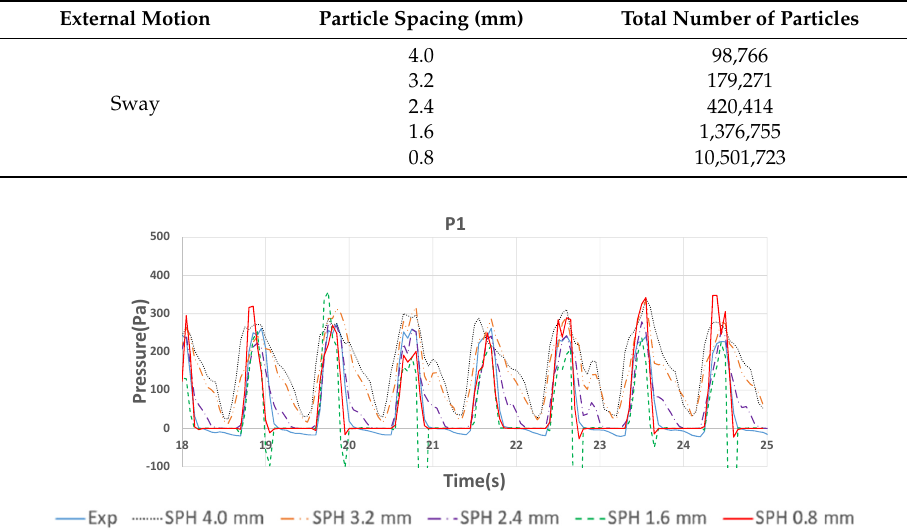
Figure 5. Convergence of dynamic pressure with respect to particle spacing for sway oscillations with f = 1.08 Hz and A = 6.52 mm. Table 3. Computational settings for DualSPHysics.